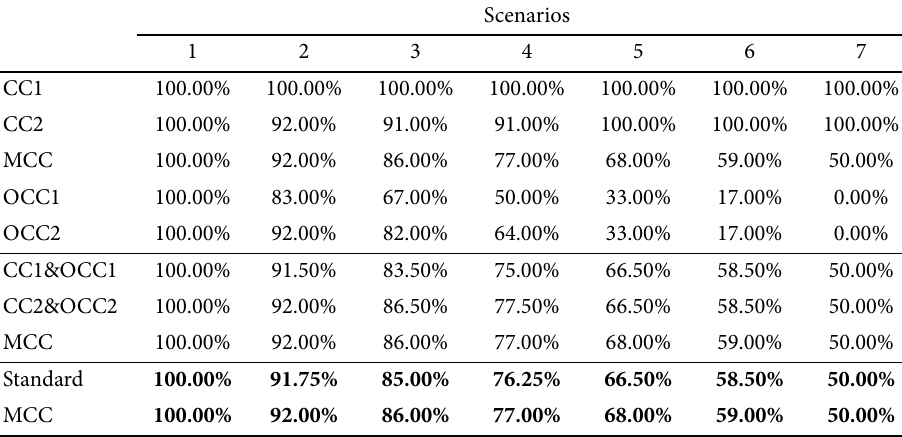
table 15. Prediction and explanation abilities of the models for